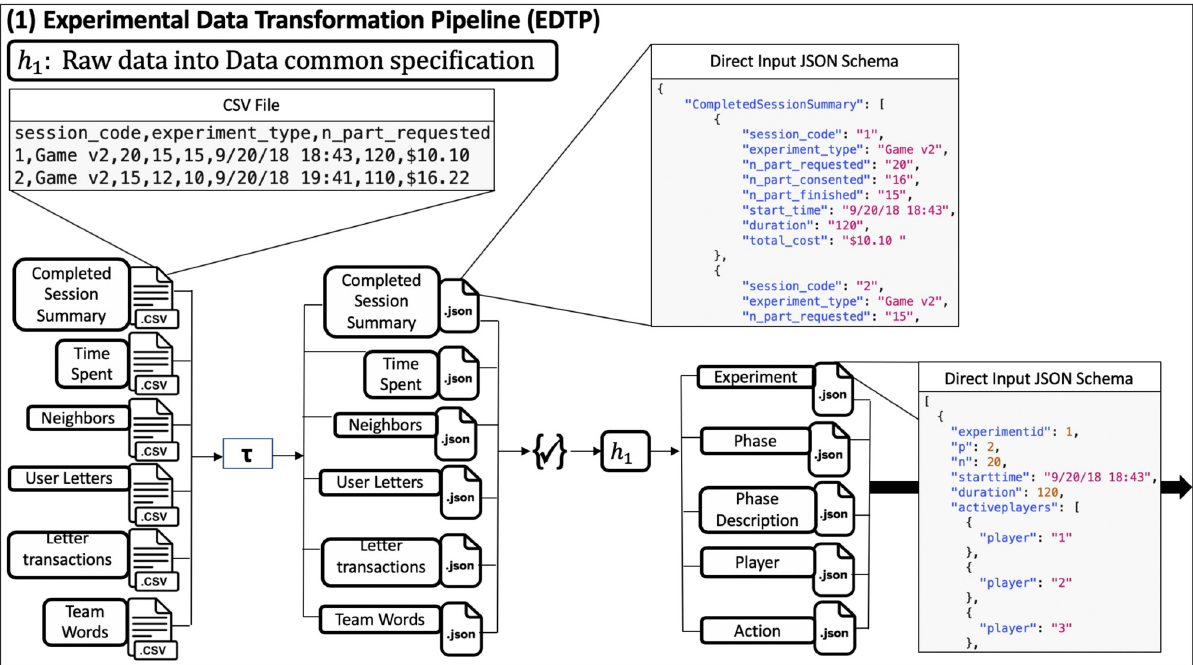
Fig 30. This is an example of the (1) experimental data transformation pipeline execution to transform raw experimental data into the data common specification. Here we show how function h 1 is executed. Here we show an input CSV file as an example for the “Completed Session Summary” input file. If necessary, file contents are transformed to obtain the direct input for a function in the correct format. Here we show how the “Completed Session Summary” CSV input file is transformed into a “Completed Session Summary” json file that becomes the input for the function. After verification of formats by the corresponding JSON schemas, the function is executed and output files are generated. Here we show the output json file for the “Experiment” data common